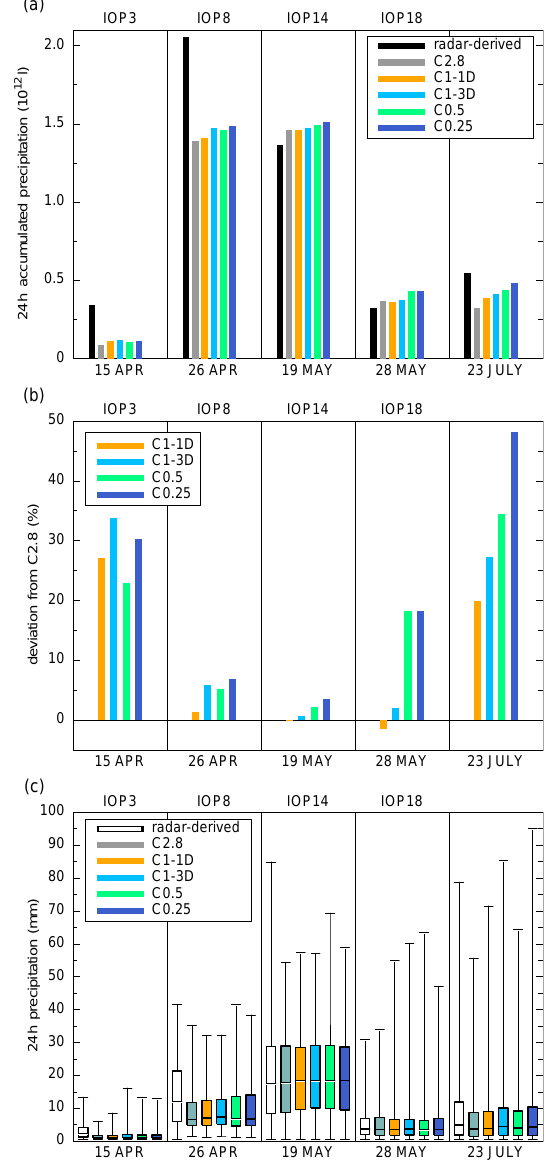
Figure 9. Domain-accumulated 24h precipitation amount (a) , de- viation from reference run (b) , and box-and-whisker diagram (c) exhibiting the median, the 25 and 75 percentiles, as well as the min- imum and maximum precipitation amounts. Note that in (c) only grid points with precipitation larger than 0.5mm are considered to prevent too small median values in case of small fractions of the area with convective